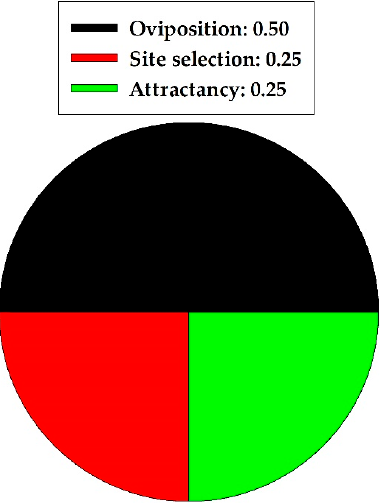
Figure 3. Oviposition behavior was affected most frequently.